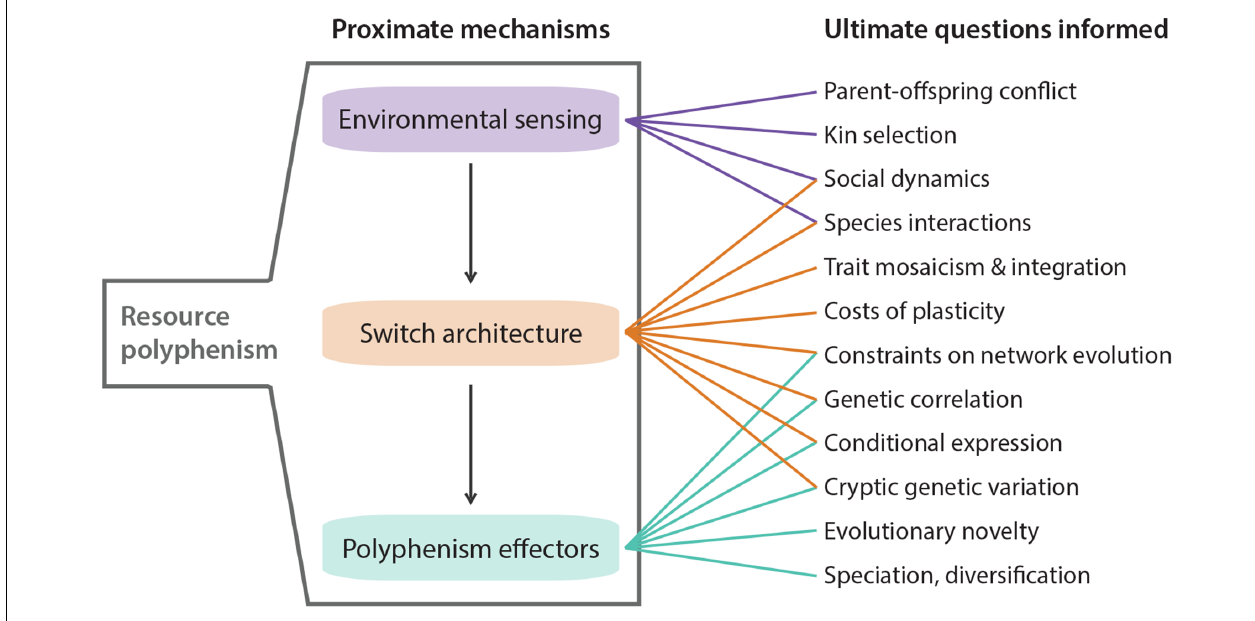
in the nematodes’ body-wall epidermis (Lightfoot et al., 2019) and, otherwise, on overall genetic relatedness (Lightfoot et al., 2021). Although the cilia of anterior sensilla are required